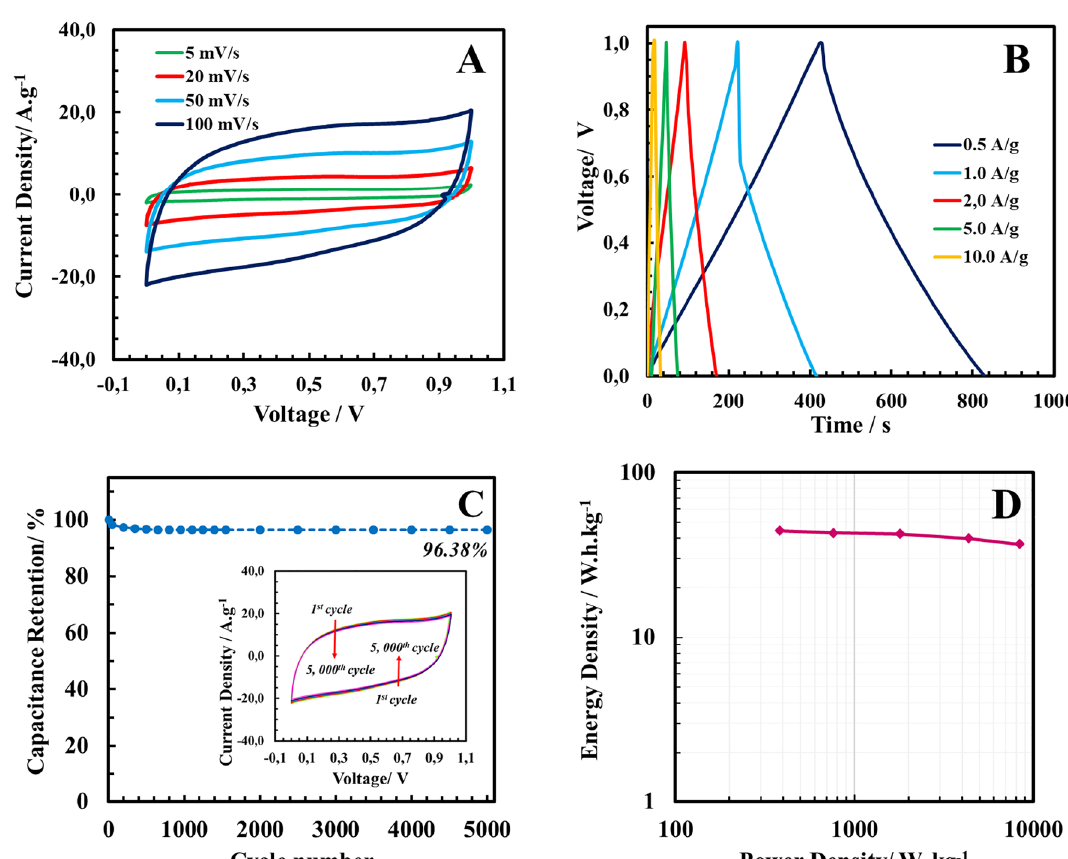
Figure 5. ( A ) Cyclic voltammograms of MWCNT/Ruthenium hydroxide aerogel at various potential scan rates ( B ) Galvonastatic charge/discharge curves at different current densities ( C ) Capacitance retention of MWCNT/ Ruthenium hydroxide aerogel for 5000 CV cycles at 100 V.s − 1 ( D ) Ragone plot of symmetric supercapacitor based on electrode active material